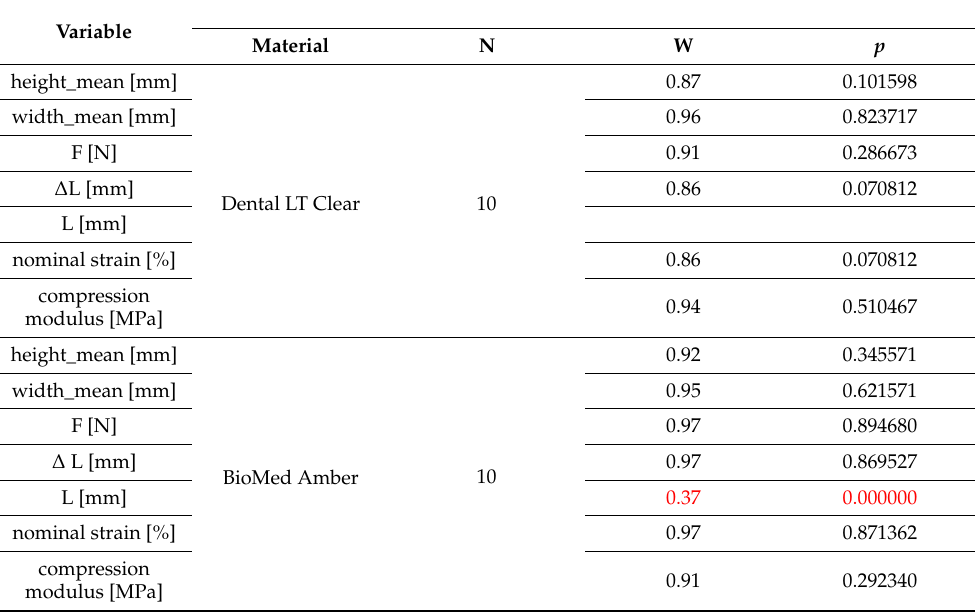
Table 1. Aggregated results on the compression test (the statistical significance for p < 0.05 was presented in